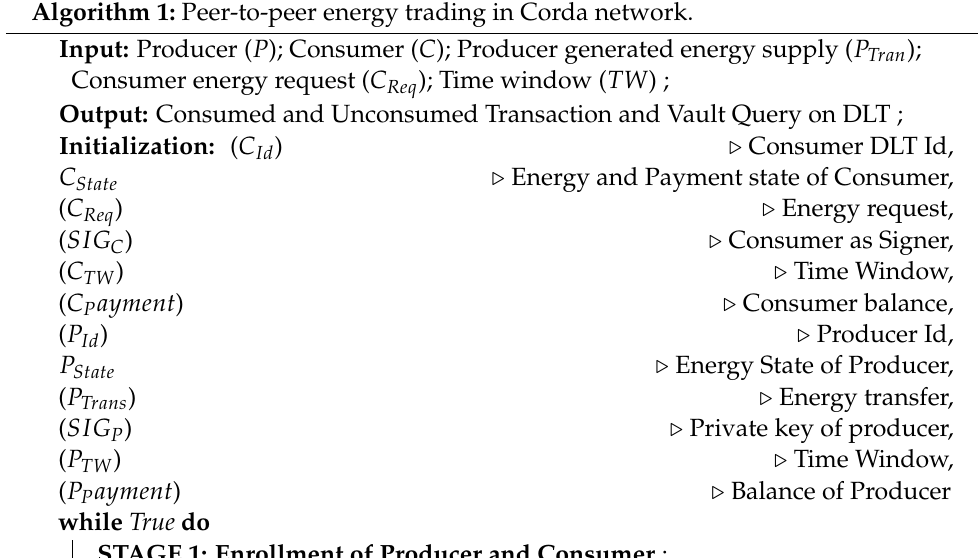
Algorithm 1: Peer-to-peer energy trading in Corda